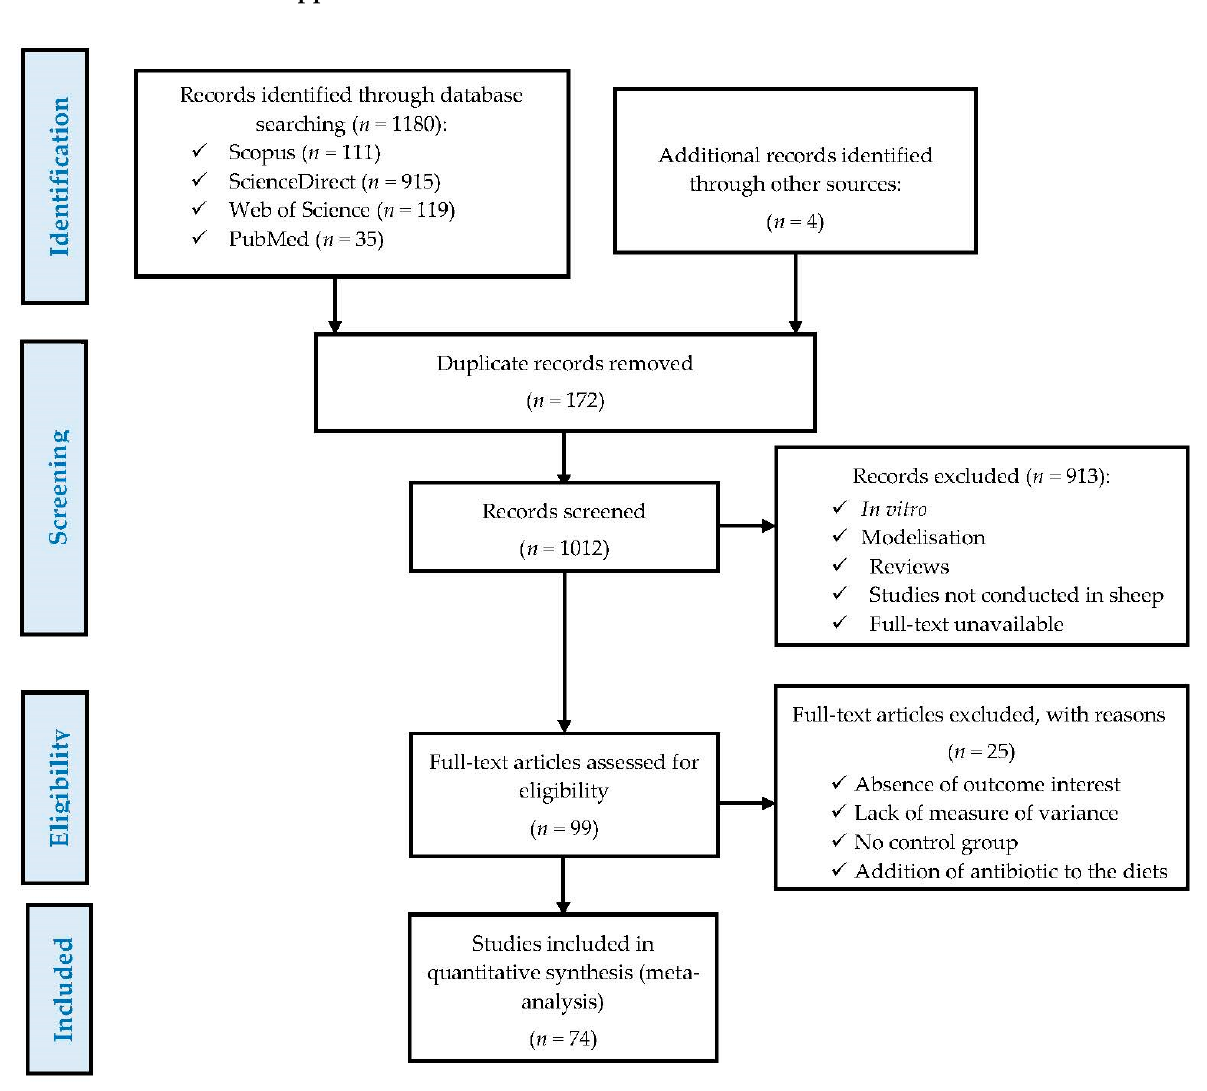
Figure A1. A PRISMA flow diagram detailing the literature search strategy and study selection for the meta ‐ analysis. Table A1. Summary of the studies included in the meta ‐ analysis.